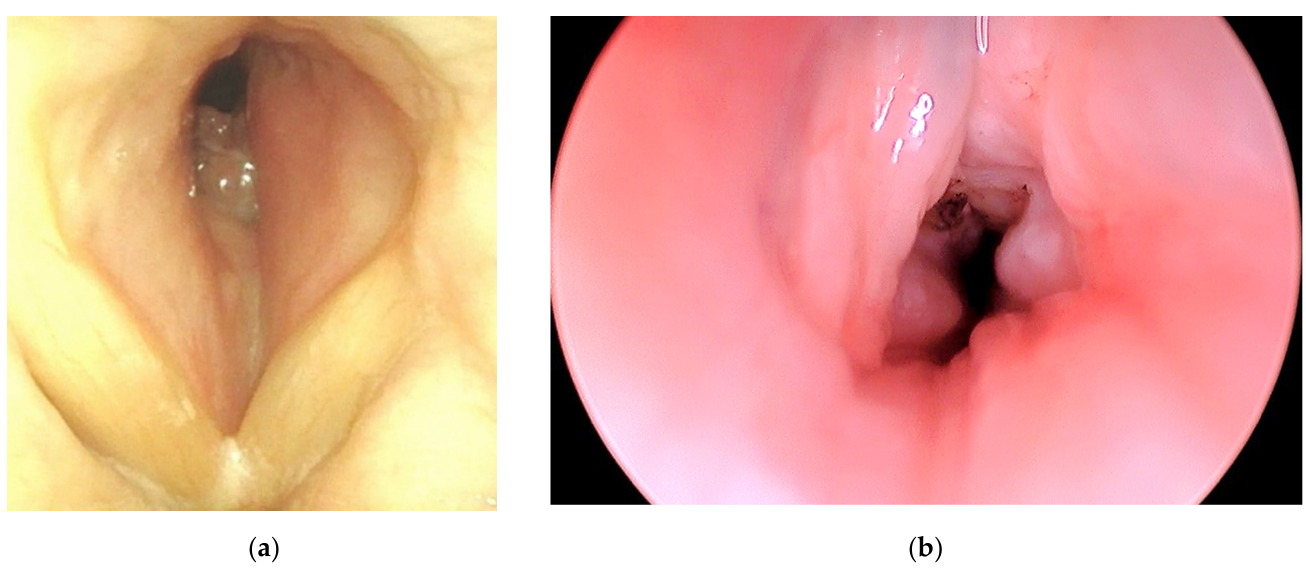
Figure 2. ( a ) Laryngoscopy at initial presentation demonstrated infraglottic edema and anterior granulation tissue causing airway obstruction; ( b ) endoscopic images of patient after last endoscopic procedure to treat infraglottic airway narrowing.